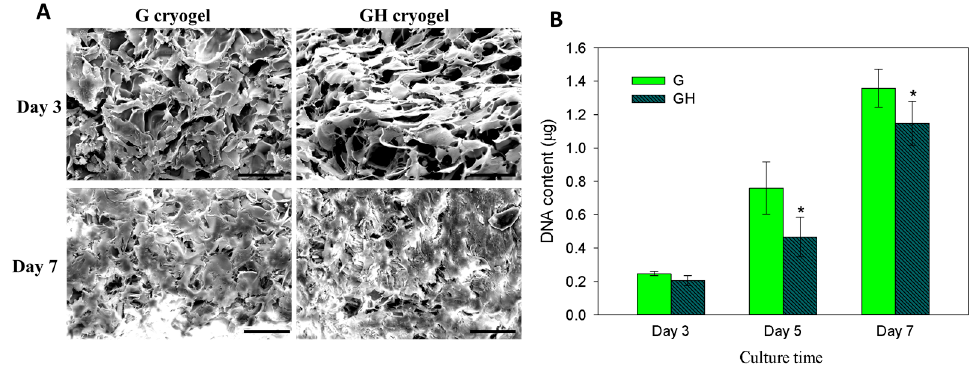
Figure 4. The cell morphology from SEM observation ( A ) and cell proliferation from DNA assays ( B ) of mesothelial cells cultured in G and GH cryogels. Bar = 50 µ m. * p < 0.05 compared with G.